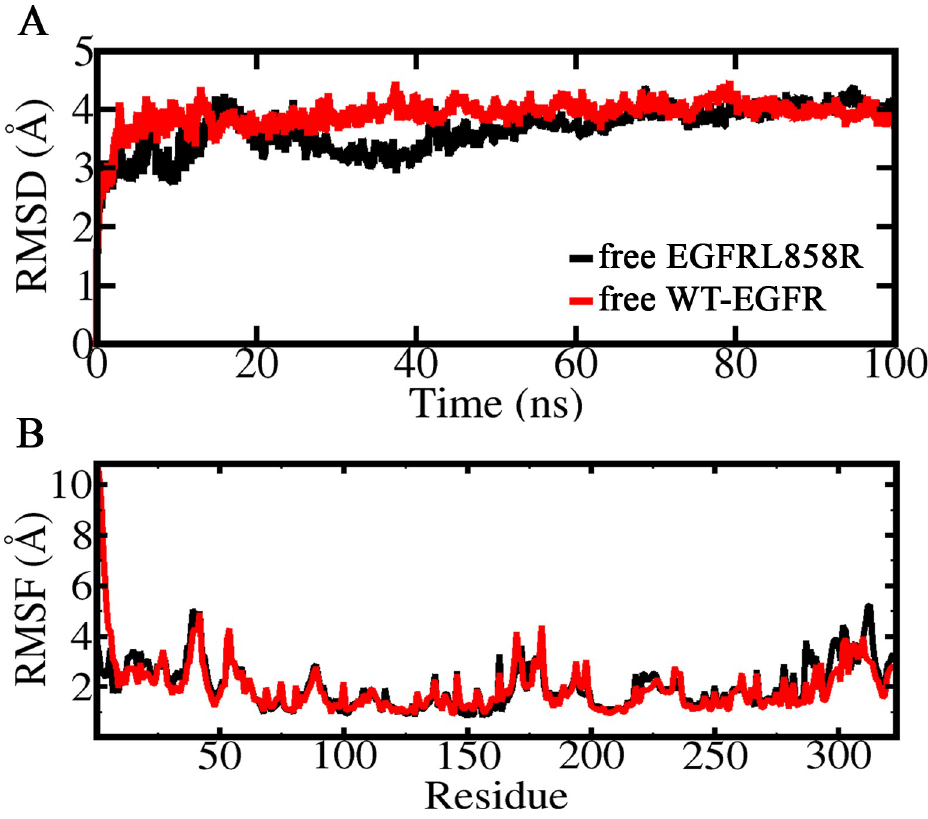
Fig 3. RMSD and RMSF of free EGFRs. (A) All atom RMSDs and (B) RMSFs of free EGFRL858R and WT-EGFR during 100 ns